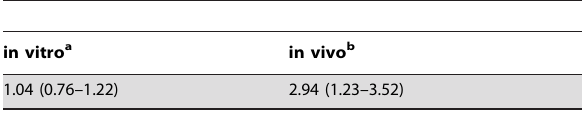
Table 4. In vitro and in vivo competition of chromosomal encoded FLAG-tagged toxR versus FLAG-tagged toxR CC mutant in El Tor